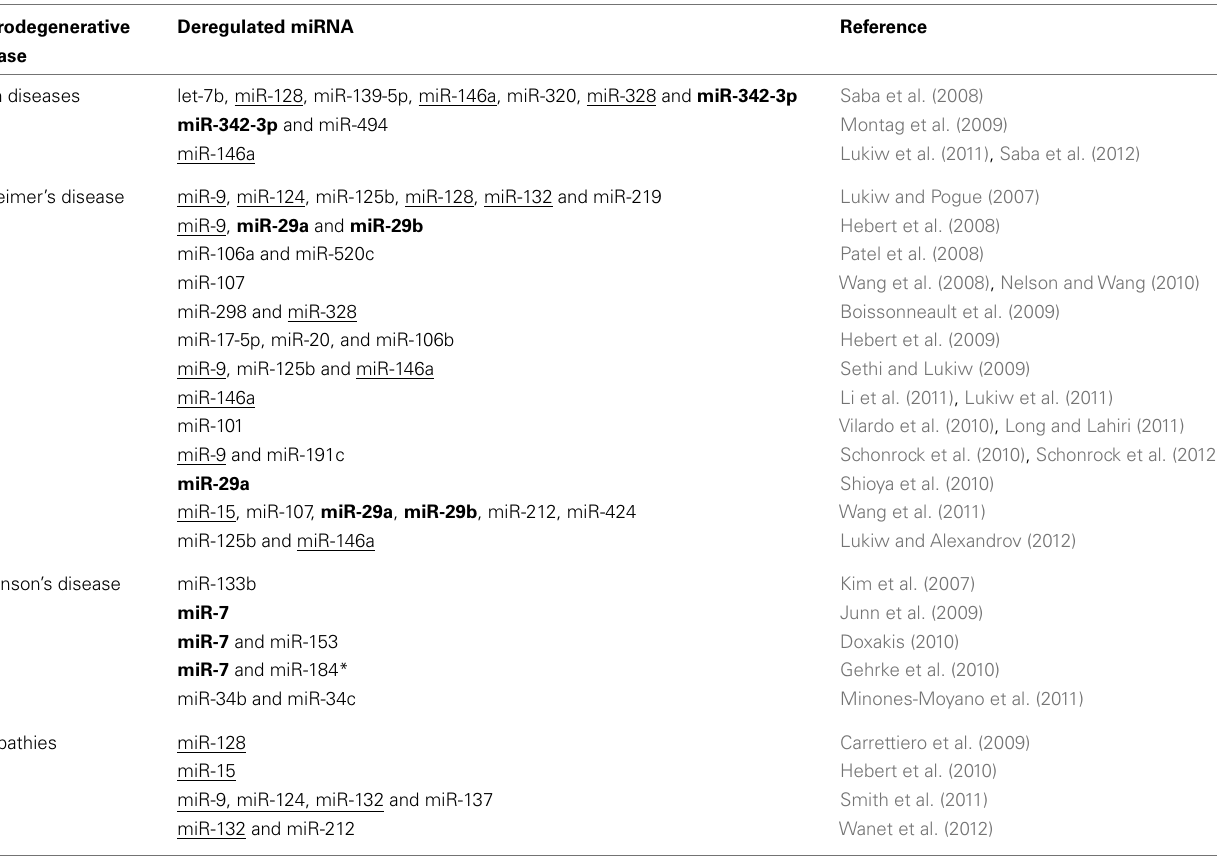
Table 2 | Dysregulation of miRNA’s in neurodegenerative diseases. Neurodegenerative